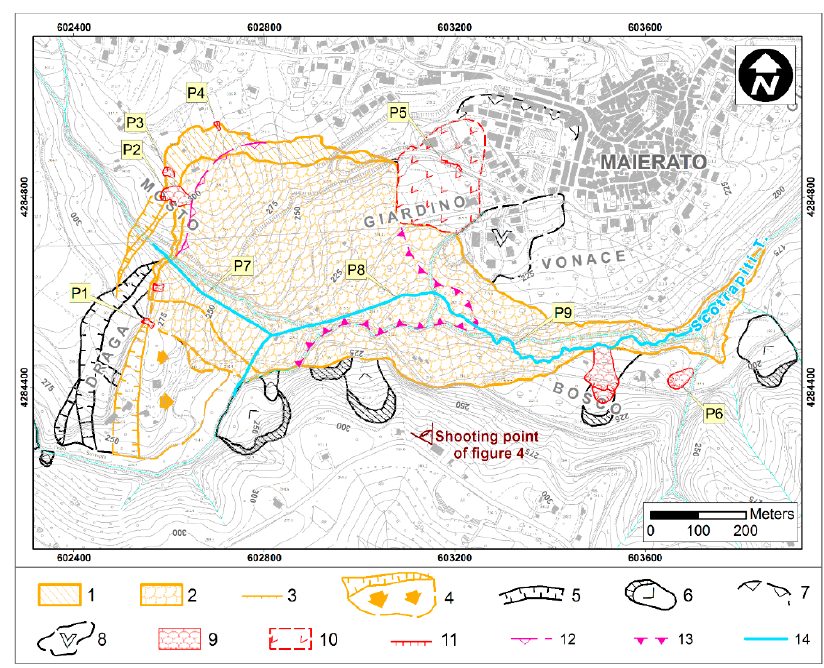
Figure 3. Landslide map and locations of the available photographs (shown in Figure 4). Legend: (1)